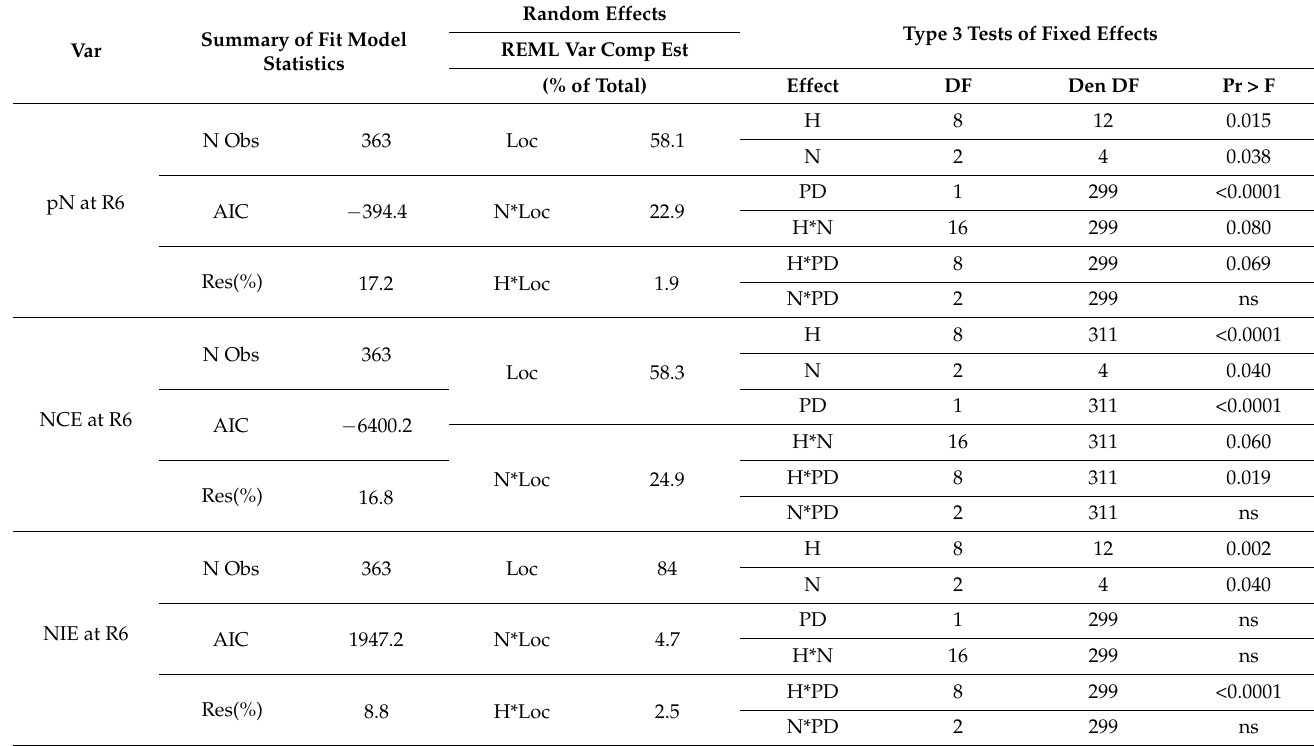
Table 5. Mixed model analysis of treatment effects (H, N, and PD) and interactions on N parameters (pN, NCE, and NIE) at R6 across 3 site-years ( α =